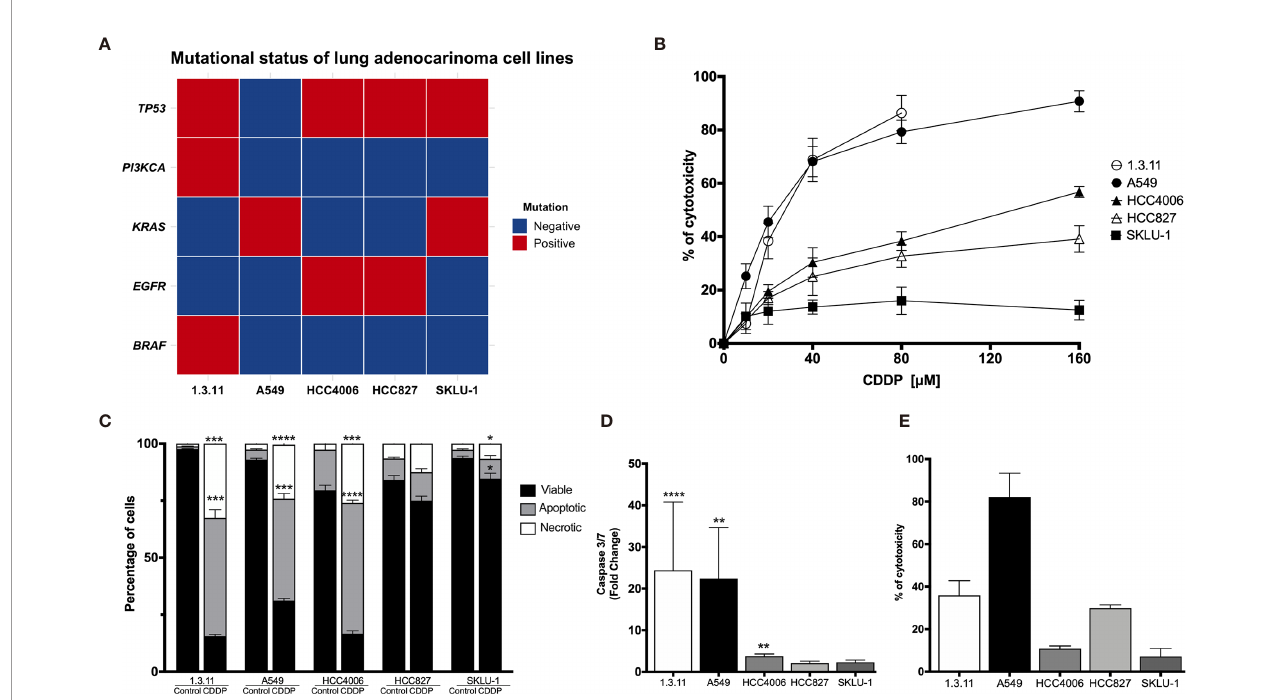
FIGURE 1 | Cell death induction in lung adenocarcinoma cell lines by cisplatin (CDDP). (A) Heat map showing clinical mutations in lung adenocarcinoma cell lines using TruSight tumor 15. Two experiments were done. (B) Dose – response curves of lung adenocarcinoma cell lines exposed to CDDP for 24 h. For detection, an MTT assay was used. Three experiments were done in triplicate. (C) Percentages of viable, apoptotic, and necrotic cells are shown. Lung adenocarcinoma cell lines were treated with the CDDP concentration that induced the highest level of apoptotic cell death. A comparison of the distinct proportions of viable, apoptotic, and necrotic cells in untreated (control) versus CDDP-treated cells is shown. Three independent experiments were done in triplicate. (D) Caspase-3/7 activity. This parameter was directly correlated with the proportion of apoptotic cells detected previously. Fold-change with respect to the fl uorescence units of CDDP-treated cells compared with that of untreated cells are shown. (E) Percentage of cytotoxicity measured by lactate dehydrogenase (LDH) enzyme activity. Supernatants from cell culture were collected following 24 h of CDDP treatment. The percentage of released LDH is indicated. Three experiments were done in triplicate. All data are shown as mean ± SD. The signi fi cant difference between treatment and control is indicated with asterisks (* p < 0.05, ** p < 0.005, *** p < 0.0005, **** p <